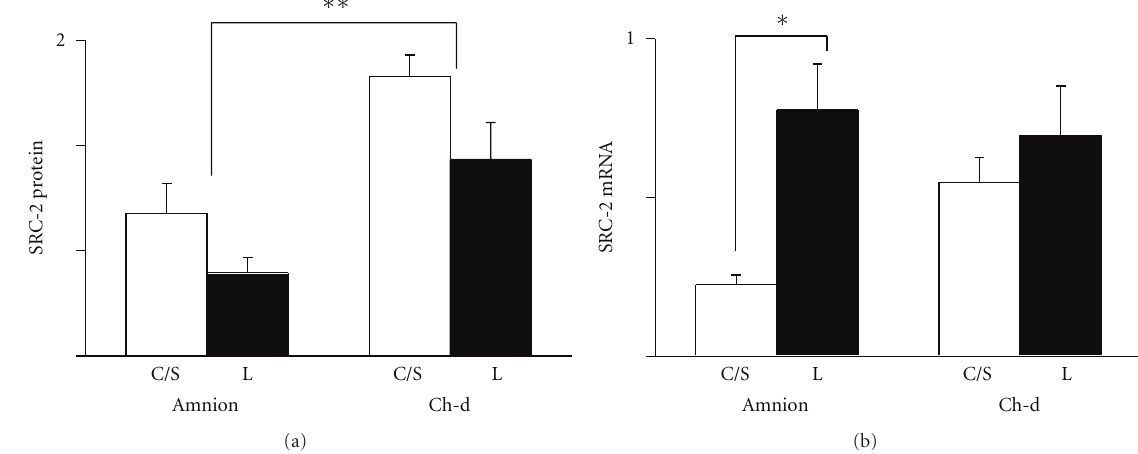
Figure 3: Expression of SRC-2 protein (a) and mRNA (b) in the amnion and chorion-decidua (Ch-d) from non-labor group (C/S) and labor group (L). Data were presented as the mean ± SEM. (a) ∗∗ P < 0 . 05 between amnion and chorion-decidua. (b) ∗ P < 0 . 05 between C/S group and labor group within the amnion. Ponceau S staining was used as the internal control for Westerns and GAPDH mRNA as the internal control for